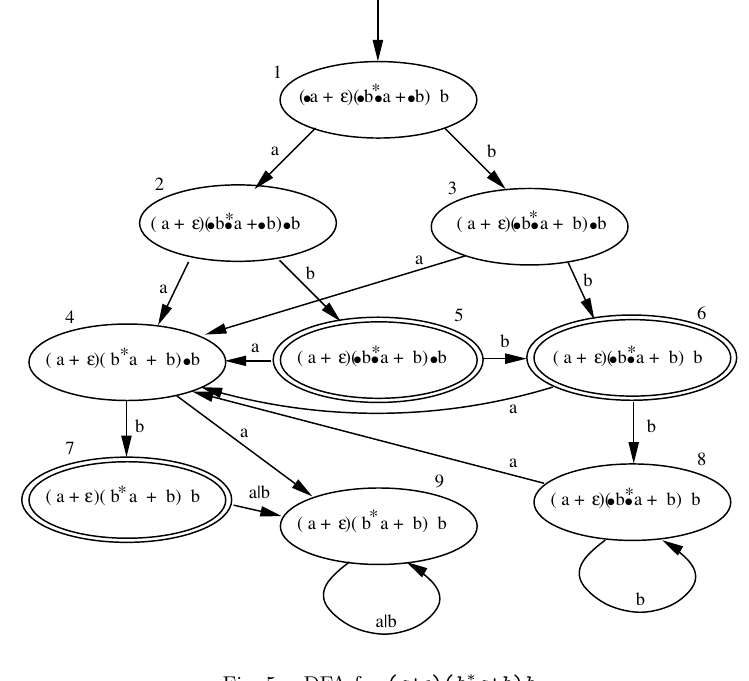
Fig. 5. DFA for ( a + (cid:15) )( b ∗ a + b )